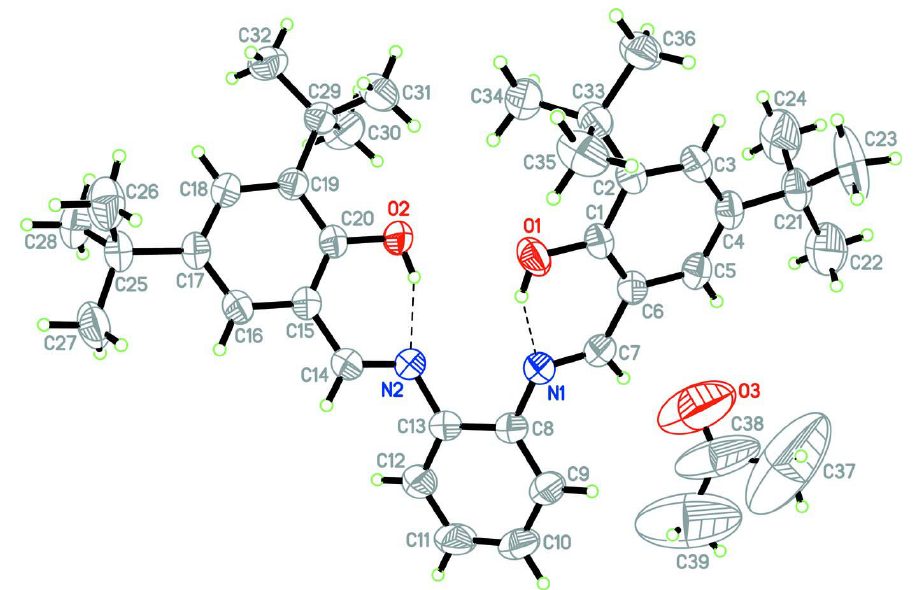
Figure 1 The asymmetric unit of the title compound, showing 50% probability displacement ellipsoids and the atomic numbering. Hydrogen bonds are shown as dashed